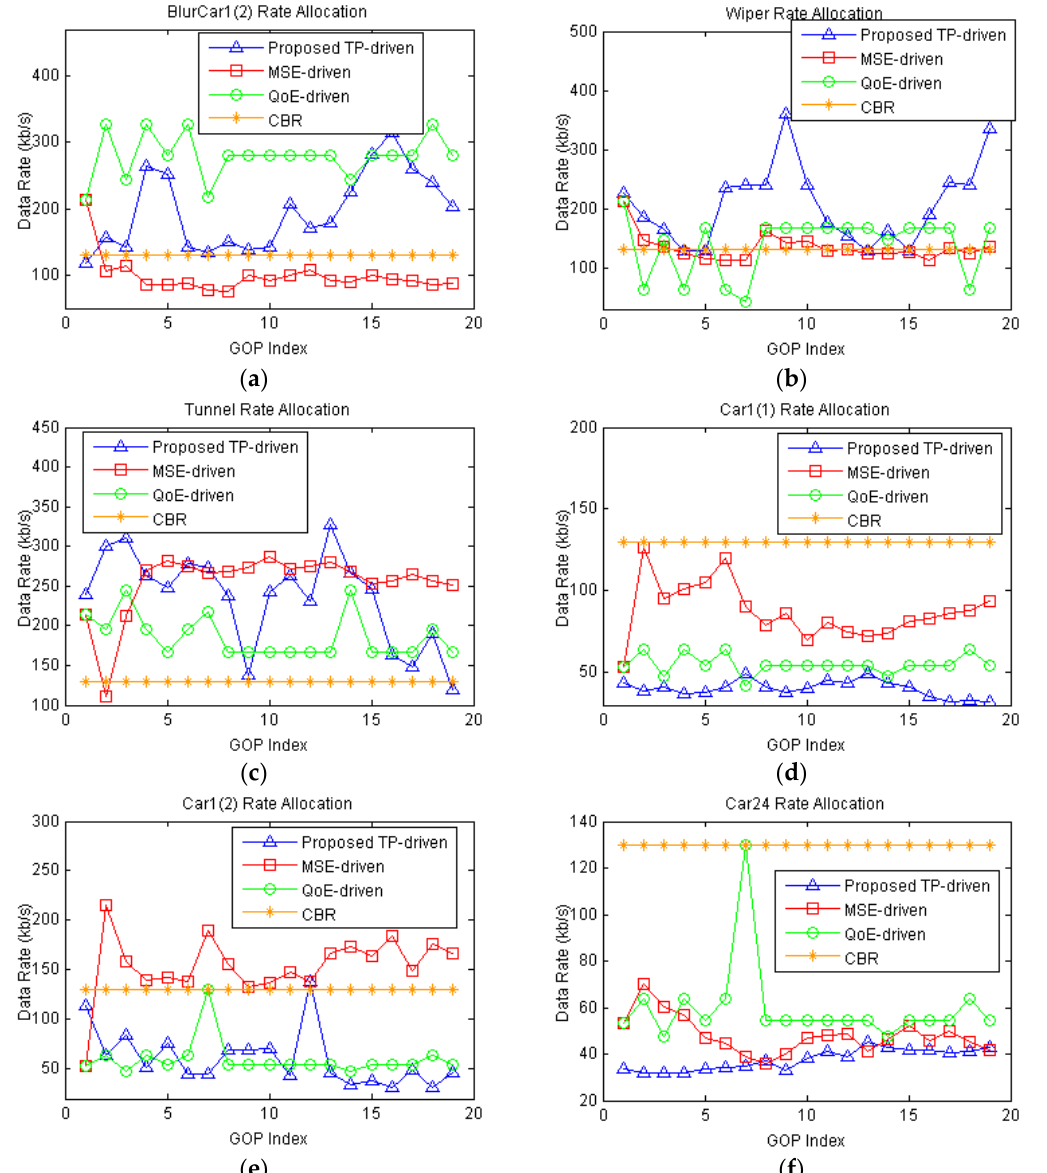
Figure 10. Source coding rate of all GOPs in each video under 800 kb/s total rate constraint. The packet loss rate of each video is 1%: ( a ) BlurCar1(2); ( b ) Wiper; ( c ) Tunnel; ( d ) Car1(1); ( e ) Car1(2); ( f ) Car24.